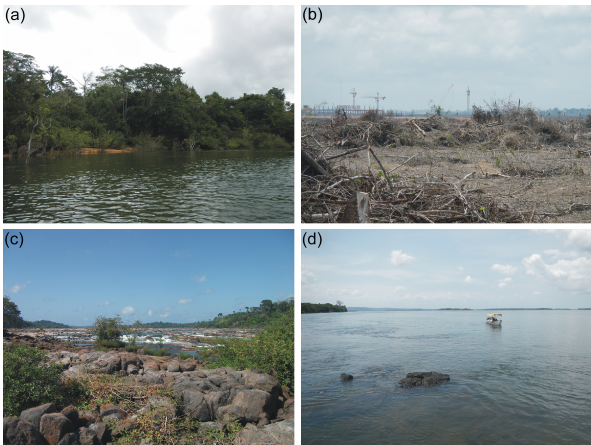
Figure 2. (a) Stabilized sediment bar (island) covered by forest vegetation nearby the Pimental dam site. (b) Deforested sediment bar to be flooded by the Belo Monte reservoir. Picture from is- land adjacent (upstream) to the Pimental dam site. (c) Rapids in the downstream sector of the Volta Grande. (d) Xingu ria downstream of the Volta Grande. Pictures taken during the dry season (Novem- ber